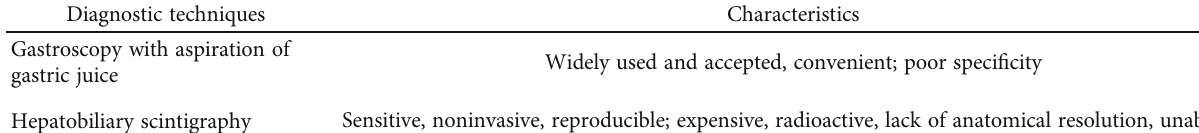
Table 1: Comparison of diagnostic techniques for BRG.